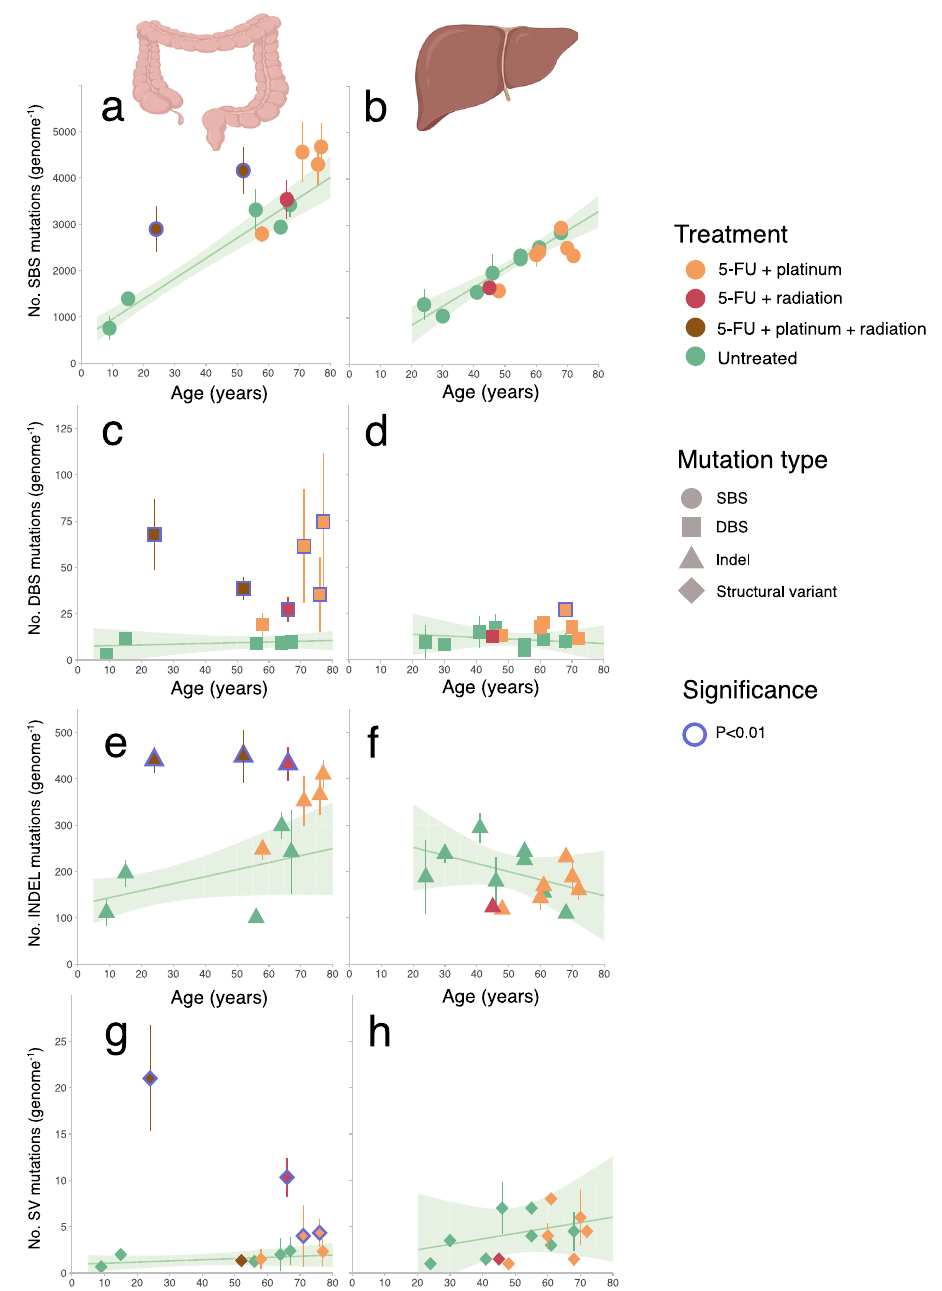
donorswhile8and7donorsareincludedforrespectivelytheuntreatedandtreated livercohort.Thegreenlinesdisplaytheexpectedmutationburdenoftheindicated mutation types calculated from untreatedASCs using a bootstrappedlinearmixed effects model (LMM) approach. The shaded areas cover the standard deviation of theLMMofthecorrespondingregressionlines.Treateddonorswithasigni fi cantly increased mutation burden (i.e., more than expected from normal aging modeled from untreated donors ( p <0.01)) are marked with blue circles. This fi gure was partlycreatedwith BioRender.com. Source data are provided asa Source Data fi